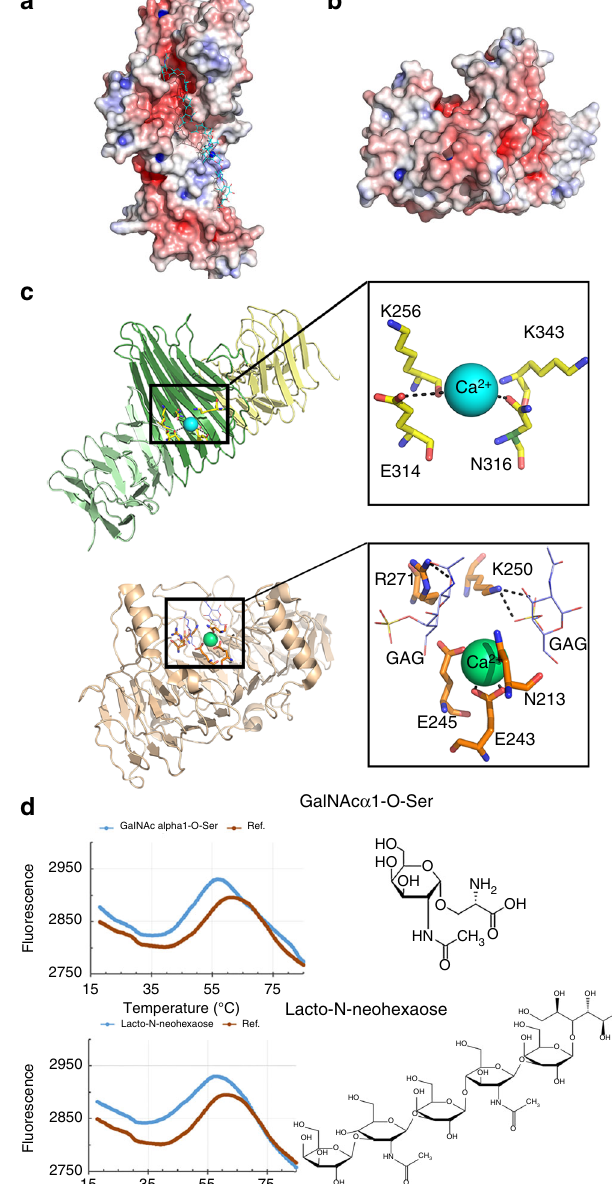
Fig. 2 UpaB can bind glycosaminoglycans. Surface representation of a α UpaB and b top view of α UpaB , with electrostatic potential coloured from the most negative (red) to positive (blue), with a range of ± 10 kT e − 1 . The β -strand extensions contributed by turns 6 – 10 and long loops protruding from between turns 2 – 6 form an acidic groove. A GAG was modelled into the α UpaB groove showing that this feature can both accommodate a GAG molecule and place it in proximity to the putative lyase active site. c Structural comparison of α UpaB (green) to P. heparinus chondroitinase B (wheat; PDB 1DBG). UpaB shares a β -helix structure, groove, bound calcium (cyan and green) and location of a putative lyase active site with chondroitinase B. UpaB has a putative GAG lyase active site (top right panel) consisting of 256 K and 343 K in proximity to a bound calcium (cyan and green) similar to that of chondroitinase B (lower right panel). d Melting curve plots showing the fl uorescence intensity (relative fl uorescence units (RFU)) of Sypro orange as a function of temperature for puri fi ed α UpaB in the presence of GalN- α 1-O-Ser and Lacto- N -neohexaose. The addition of these compounds resulted in a T m shift of − 3.23 and − 3.67 °C, respectively (mean T m shift of the 88 carbohydrates screened was <0.7